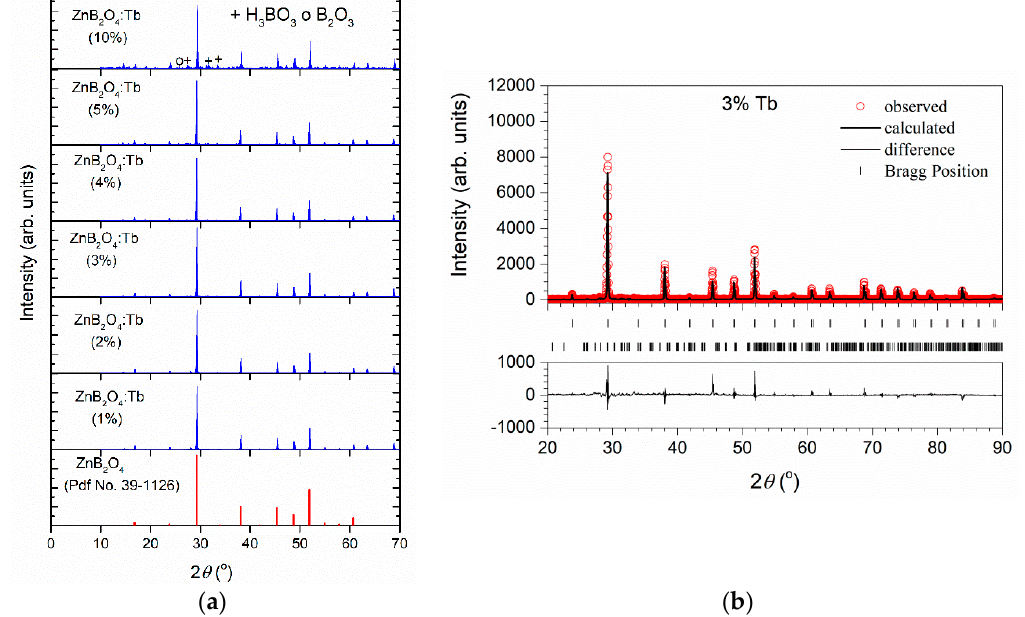
Figure 1. (a) XRD patterns for ZnB 2 O 4 :Tb 3+ phosphors. The standard XRD pattern of ZnB 2 O 4 is taken Figure 1. ( a ) XRD patterns for ZnB 2 O 4 :Tb 3 + phosphors. The standard XRD pattern of ZnB 2 O 4 is taken from JCPDS Card No. 39-1126. (b) The refined XRD pattern of ZnB 2 O 4 :0.03Tb 3+ sample. from JCPDS Card No. 39-1126. ( b ) The refined XRD pattern of ZnB 2 O 4 :0.03Tb 3 +